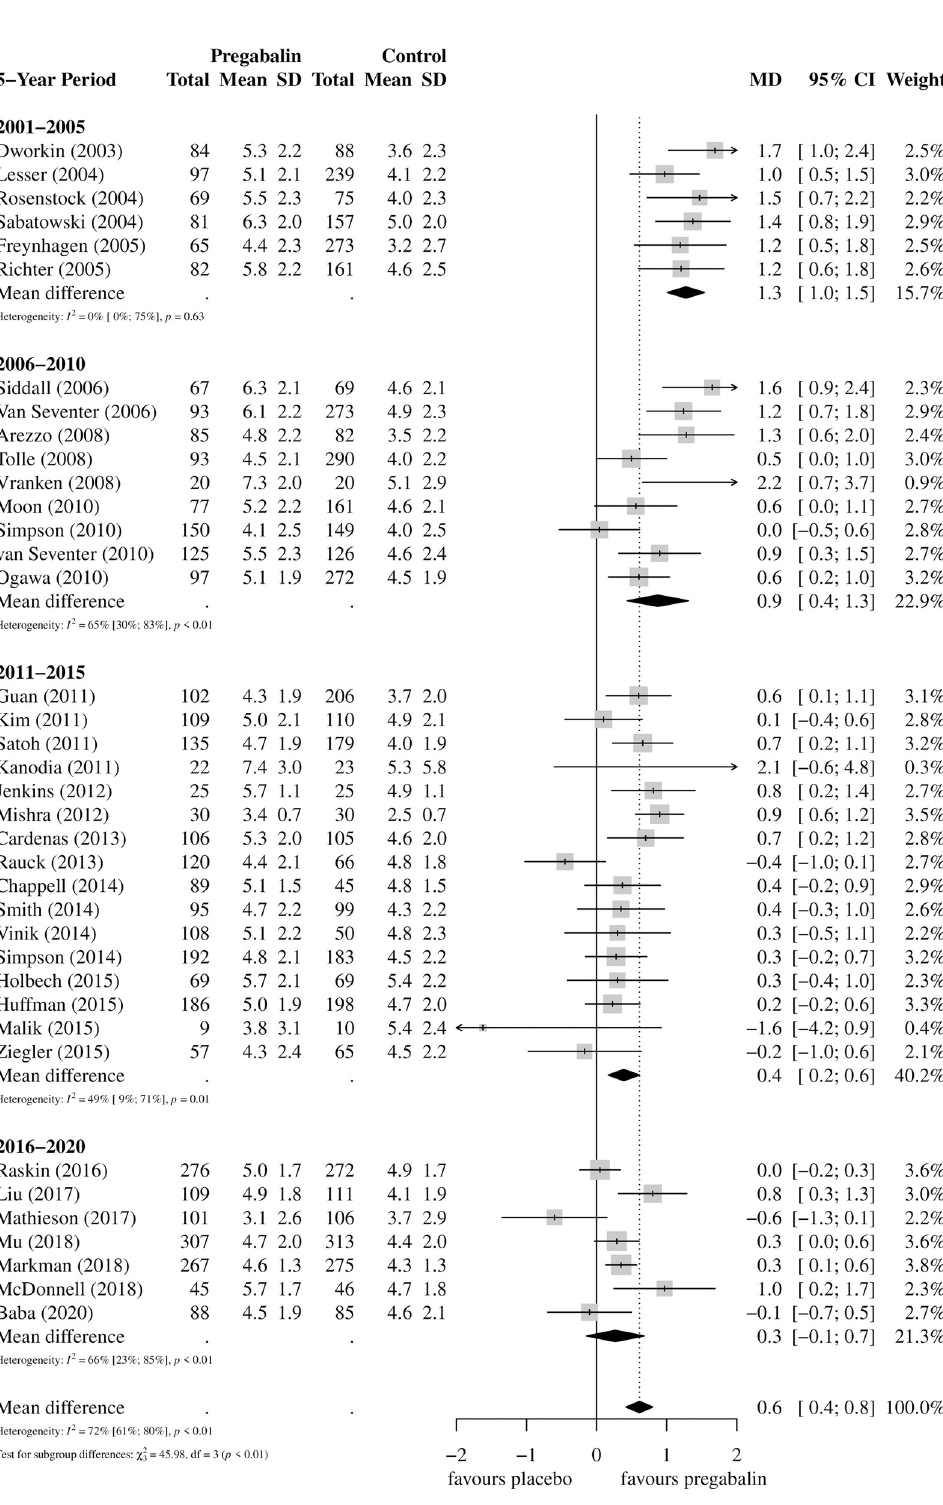
Fig 3. Forest plot of reported treatment effect � of pregabalin by 5-year interval and overall. � Treatment effect defined as: mean difference (MD) in end-point pain scores between pregabalin and placebo. Abbreviations: SD, standard deviation; MD, mean difference; 95% CI, 95% confidence